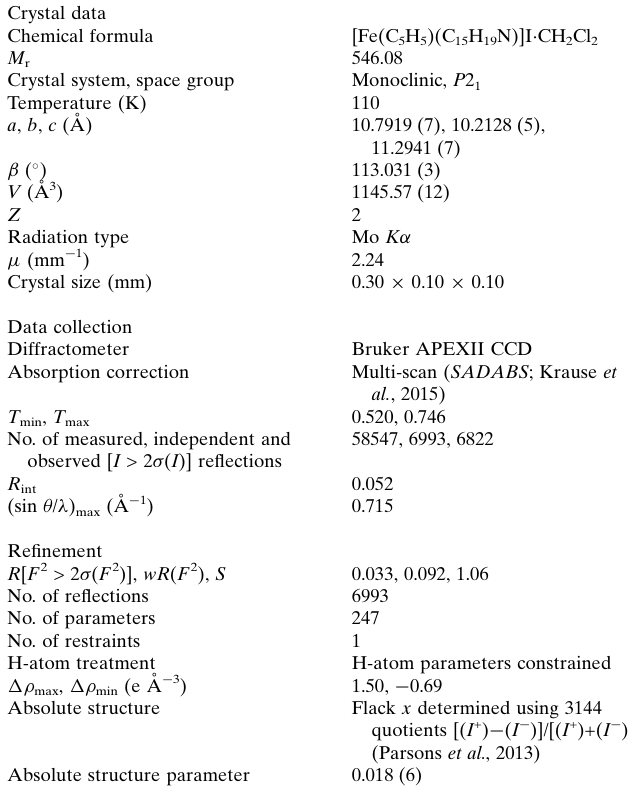
Table 2 Comparison of the geometry (A˚ , (cid:4) ) within the methylamine C–CH 2 –N fragment for the title compound with related